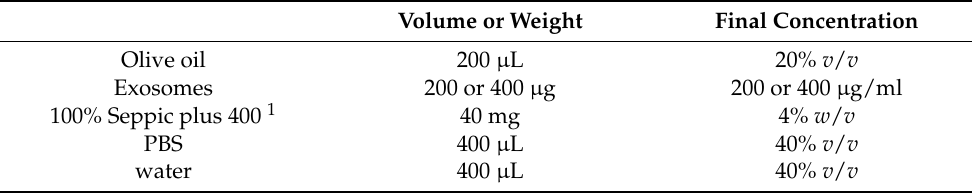
Table 1. Formulation of oil-in-water emulsion of MSC